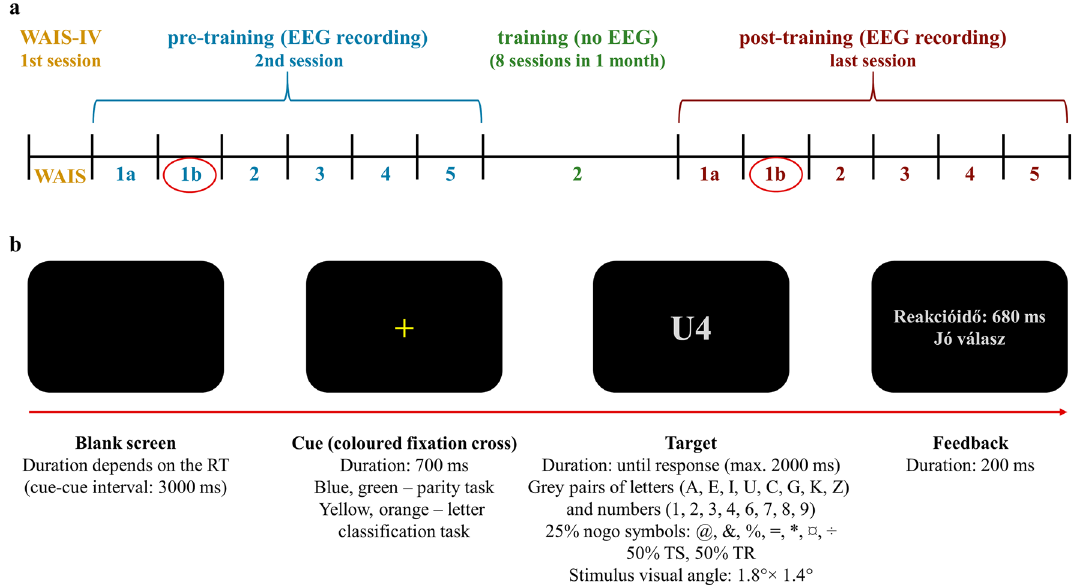
Figure 1. Experimental design of the adaptive task-switching training study 27 . ( a ) The structure of the executed tasks. Sitting with eyes closed (1a) and open (1b) for 2 min each, (2) informatively cued task-switching paradigm with no-go stimuli—letter classification and parity task (trained task), (3) non-informatively cued task-switching paradigm with no-go stimuli—letter classification and parity task, (4) informatively cued task- switching paradigm—colour and shape classification, and (5) Attentional Network Test. In the training sessions the difficulty of the informatively cued task-switching paradigm with no-go stimuli was modified block by block based on performance. The resting-state EEG with eyes open from pre- and post-training sessions (1b) were analysed in this study. ( b ) The schema of the informatively cued task-switching paradigm with no-go stimuli— letter classification and parity task (trained task). TR: task-repeat, TS: classification (this task was used for detecting near-transfer effects in the original study, and it was not trained), and (5) Attentional Network Test (this task was used for detecting far-transfer effects in the original study, and it was not trained). Each task began with a practice block where participants were given the instructions both orally and in writing. In connection with the current study’s goals, we are focusing on the trained, informatively cued task-switching paradigm with no-go stimuli, thus we describe it in more detail here (Fig. 1). Every trial started with a coloured cue where yellow and orange cues were assigned to the letter classification task (vowel/consonant decision) and blue and green cues to the number classification task (odd/even decision). After 700 ms, a letter-number target pair was shown in the centre of the screen. Participants pressed the button of a game pad with their left or right index finger based on the mapping of the letter and parity task which was counterbalanced. In all trials except four per block, the two stimuli required opposite button presses. In 25% of the trials, special characters were shown as targets where response had to be withheld (nogo trial). The target was shown until response (maximum 2,000 ms) and feedback was displayed post-response on the screen for 200 ms. The paradigm had the following restrictions: (1) cue colour was never repeated in successive trials, (2) target stimuli were presented in pseudor- andom order with no repetition on successive trials, (3) 50% switch probability, (4) two nogo trials could not follow each other, (5) maximum three switch or repeat trials could follow each other. Two blocks of single letter, and two blocks of number classification trials were presented at the beginning of each session (104 trials each). These were followed by 10 blocks of mixed trials (50 trials per block). While the control groups participated only in the aforementioned three sessions (passive control), the train- ing groups completed eight 1-h adaptive training sessions of the informatively cued task-switching paradigm with no-go stimuli. The difficulty level was personalized in each block based on the current performance of each participant and it varied based on the number of tasks (1–4) and the number of cues for each task (1–2): (1) parity task—odd/even number decision (blue and green cue), (2) letter classification task—vowel/consonant decision (yellow and orange cue), (3) magnitude task—less/more than five decision (lilac and pink cue), (4) letter classification task—lower/uppercase decision (red and brown cue). This adaptive cognitive training took place between the second and last session for every participant who underwent training. Thus, we refer to these sessions as pre-training (first and second sessions) and post-training (last session). For the current analyses, we used the pre-training open-eyed resting-state EEG data for detecting general age-related differences in the neural network dynamics, as well as pre- and post-training open-eyed resting- state EEG data in order to examine training-related changes in the neural network dynamics and its age-related modifications. Additionally, we used the informatively cued task-switching with no-go stimuli (letter/parity decision) task’s cue- and target-locked event-related potentials (ERPs) from pre- and post-training conditions for detecting those electrodes where training-related changes could be detected. We focused on this task because it was used in the adaptive training, thus its cue-and target-locked ERP data could reveal training-related changes